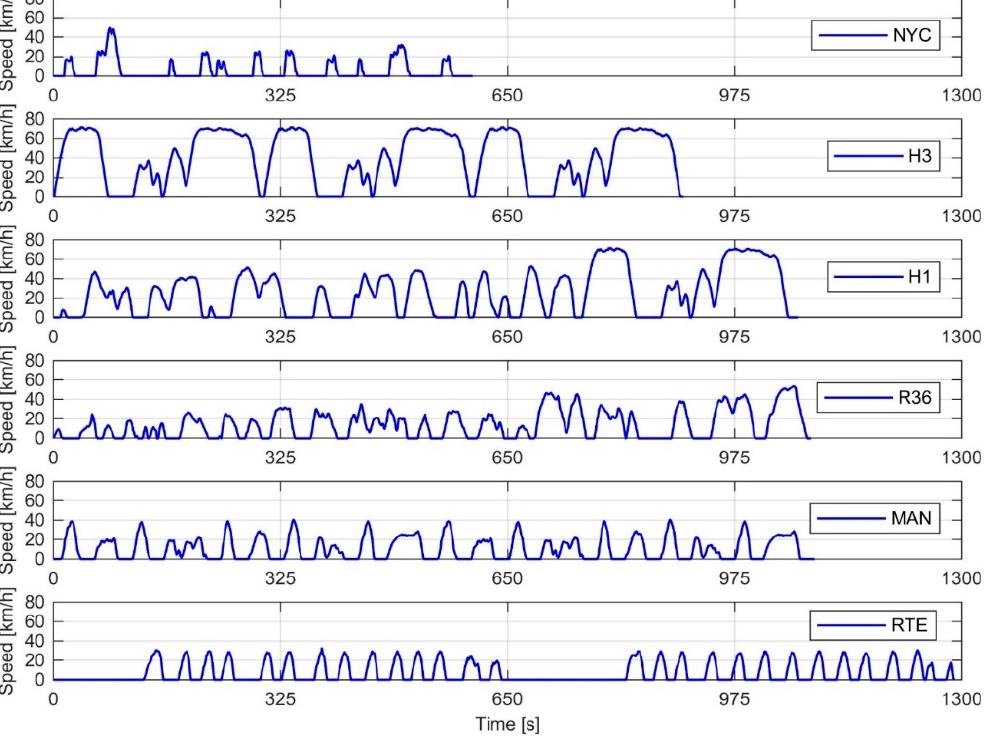
Figure A1. City bus driving cycles with a maximum duration of 1300 s.